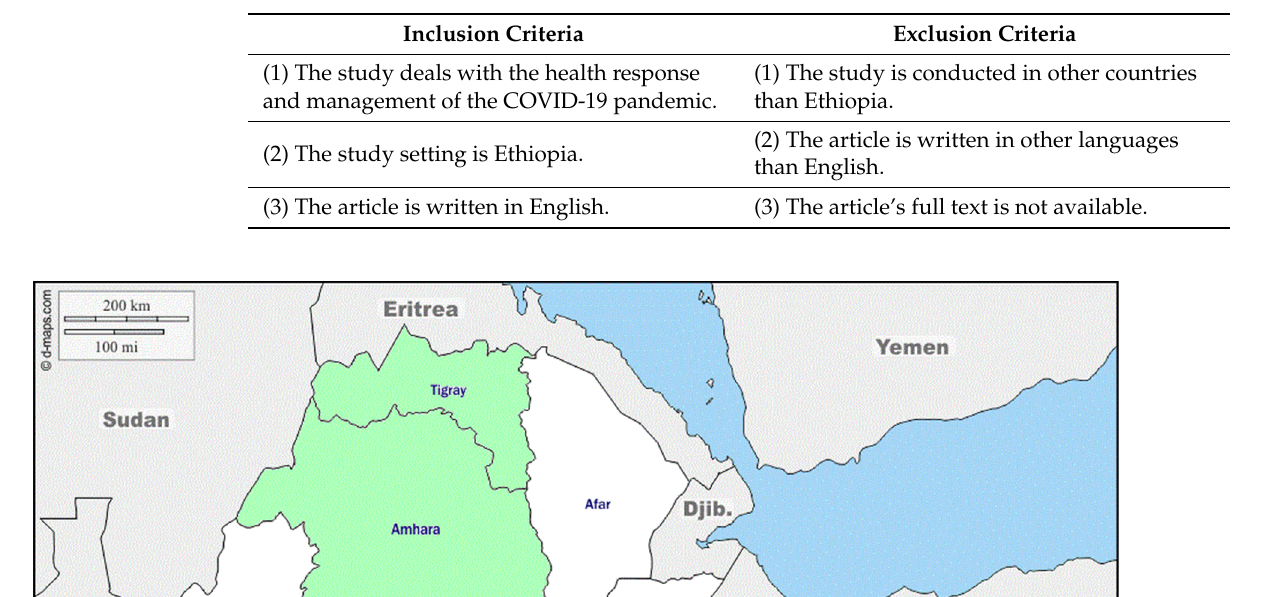
Table 1. Inclusion and exclusion criteria.